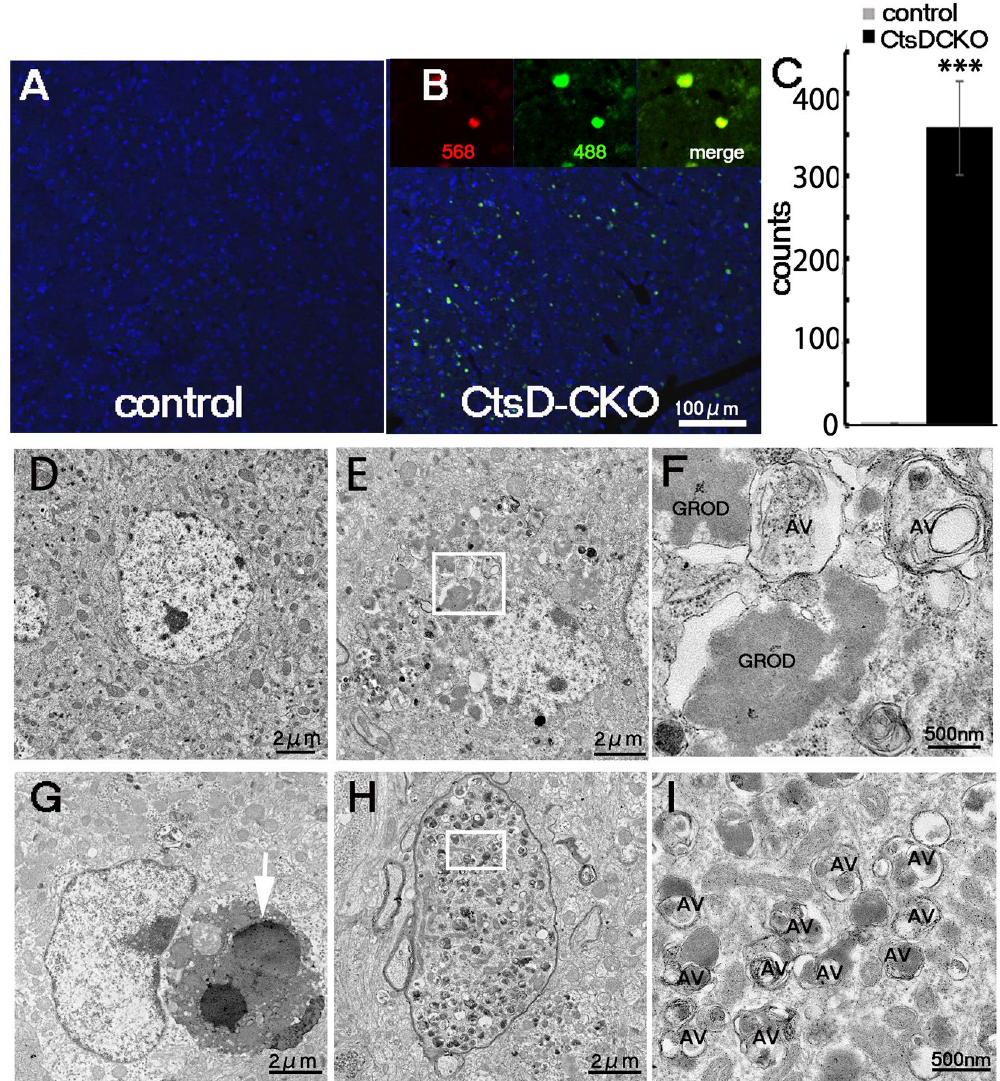
Figure 2. Accumulation of autofluorescent materials in the thalamus of CtsD-CKO mice. Representative images of lipofuscin autofluorescence in the thalamus of CtsD-CKO mice at p23 is shown in ( B ), as compared with that in control mice ( A ). Insets in ( B ) are higher magnified images of autofluorescence by confocal microscopy using light at 568 and 488 nm for excitation. “Merge” is a merged image of the two (568 and 488). Autofluorescent puncta in the thalamus were quantified. (***p < 0.001, from p19 to p25, n = 3 sections form separate mice) ( C ). Representative electron microscopic images of control ( D ) and CtsD-CKO mouse thalami ( E – I ) at p25 are shown. ( E ) and ( F ) show representative images of neurons in CtsD-CKO mouse thalamus, which contains numerous dense bodies, resembling granular osmiophilic deposits (GROD), and vacuolar/ autophagosome-like structures (AV). A phagocytic cell possesses a degenerated flatten nucleus (white arrow) ( G ). ( H ) and ( I ) show a spheroid-like axon containing numerous AVs and with thinner myelin. ( F ) and ( I ) are higher magnification images of the boxes in respective ( E ) and ( H